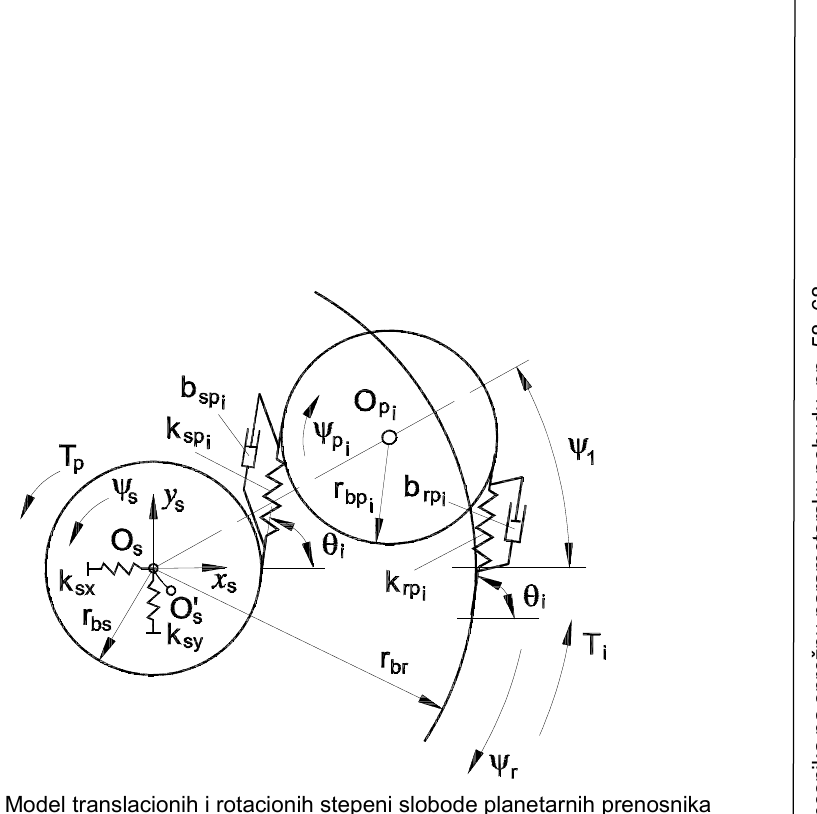
Figure 6 – Translational and rotational degrees of freedom model of planetary